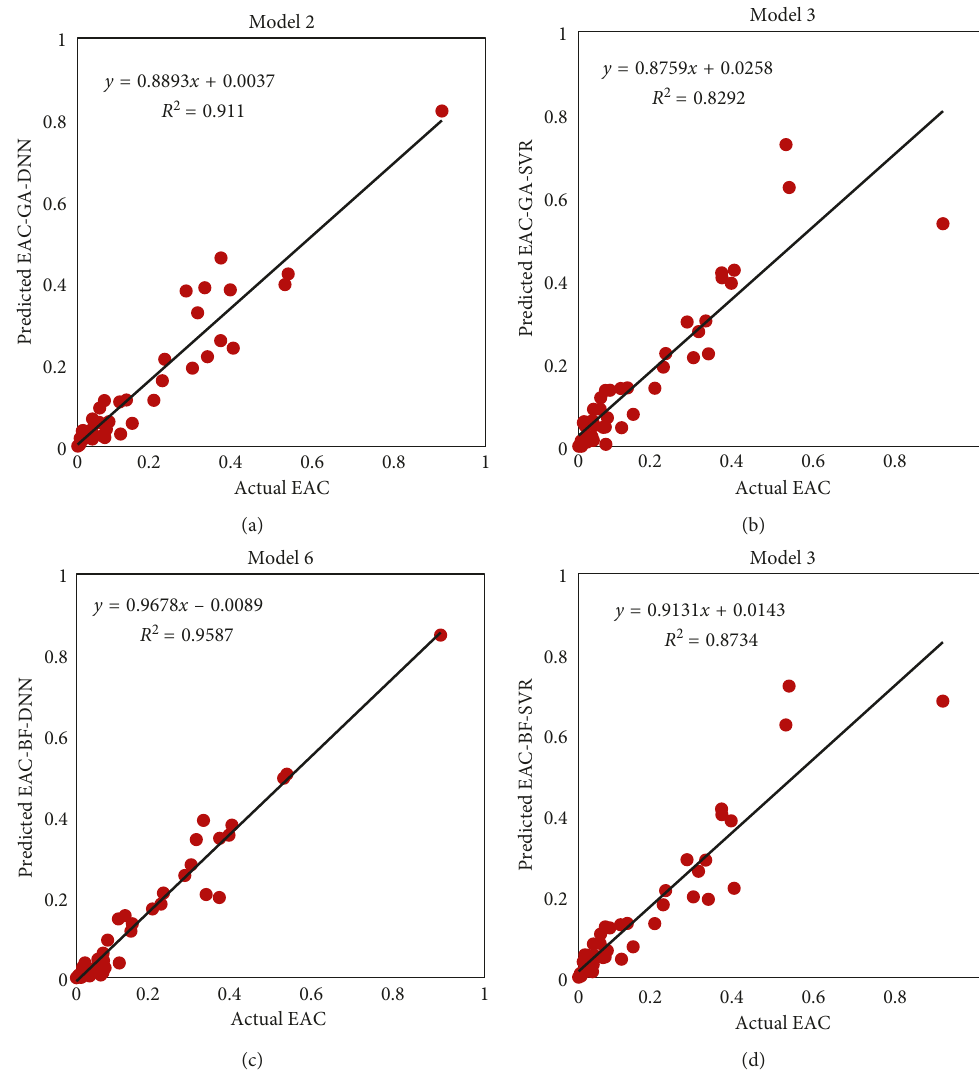
Figure 5: The scatter plot graphical visualization between the actual observation of EAC and the intelligence predictive models: (a) optimal input combination for GA-DNN; (b) optimal input combination for GA-SVR; (c) optimal input combination for BF-DNN; (d) optimal input combination for